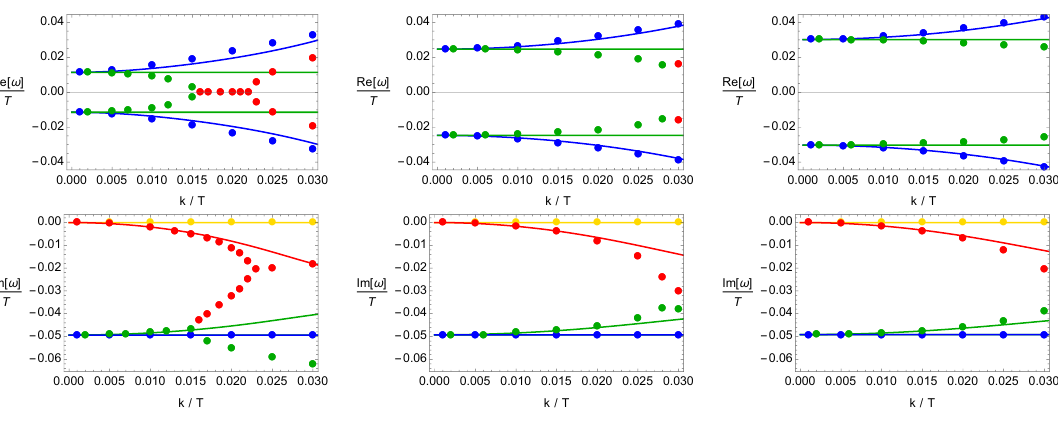
Figure 6 . Dispersion relation of the lowest QNMs. Left, center and right panels correspond respectively to µ/T = 0 . 57 , 0 . 62 , 0 . 65